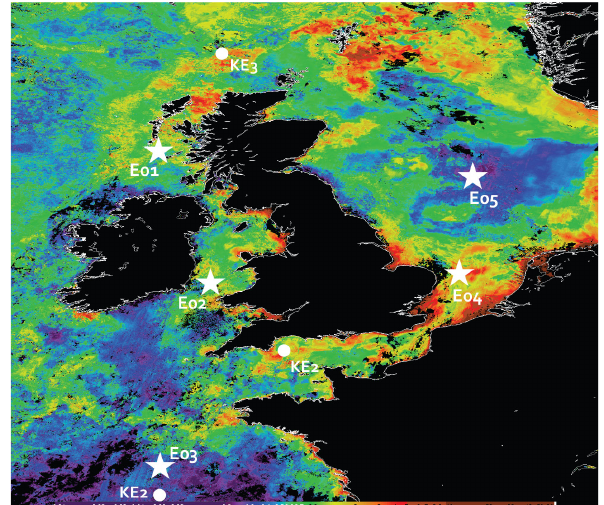
Figure 1. Locations of sampling in NW European shelf waters for bioassay experiments (white stars, E01–E05) and for kinetic exper- iments (white circles, KE1–KE3). Map shows Medium Resolution Imaging Spectrometer (MERIS) chlorophyll composite for period 6–12 June 2011 as a representative week of the sampling period (8 June–5 July 2011). Satellite image courtesy NERC Earth Observa- tion Data Acquisition and Analysis Service